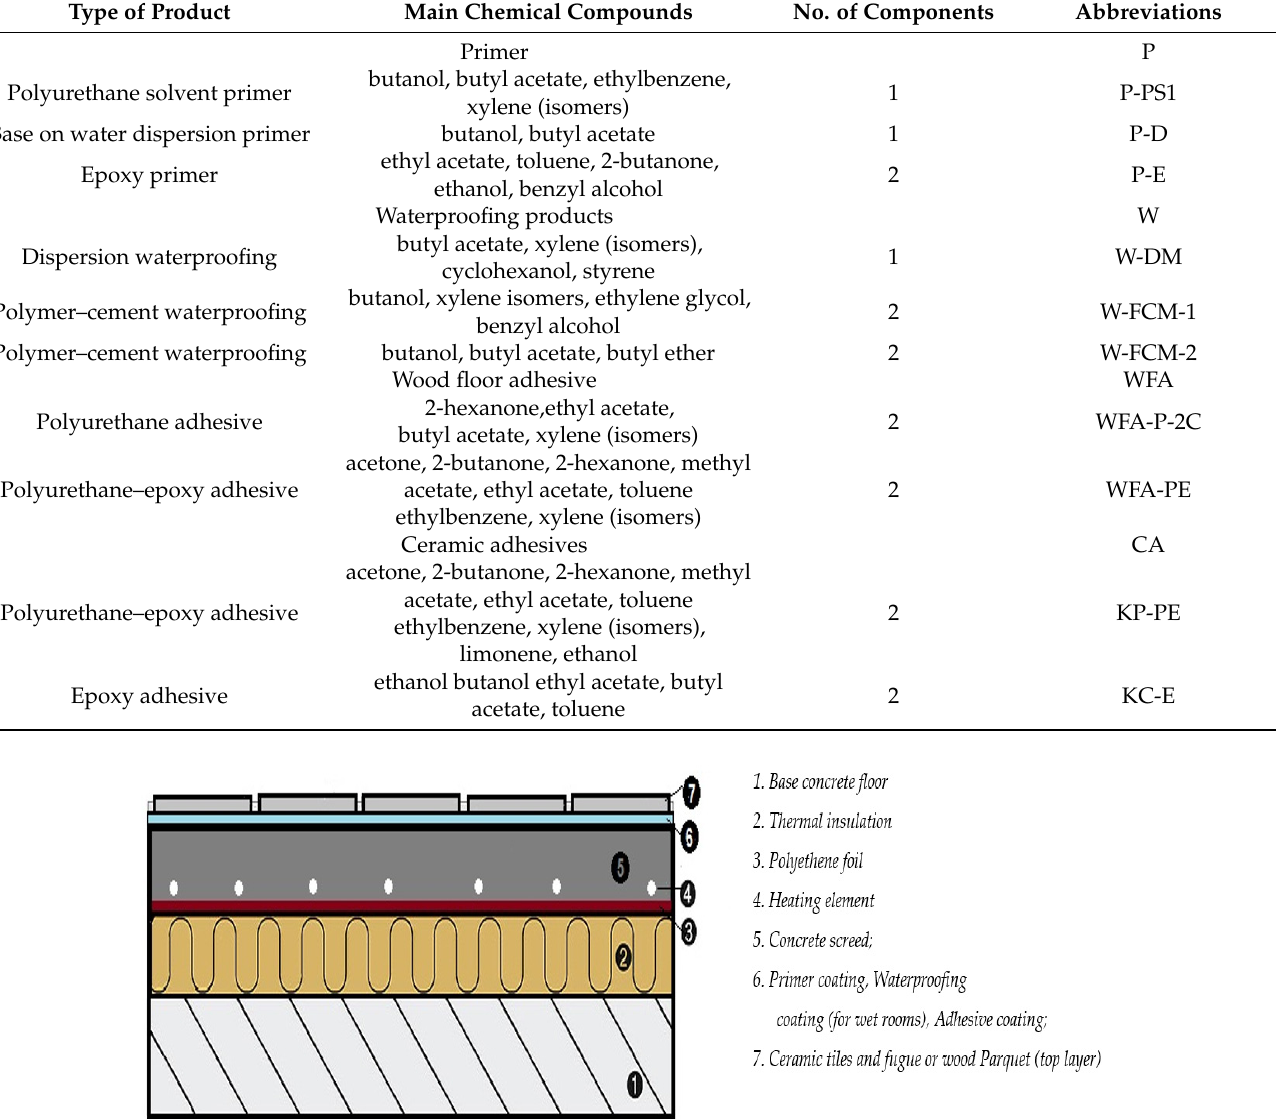
Figure 1. Installation scheme for electrically powered radiant floor heating multilayers system.